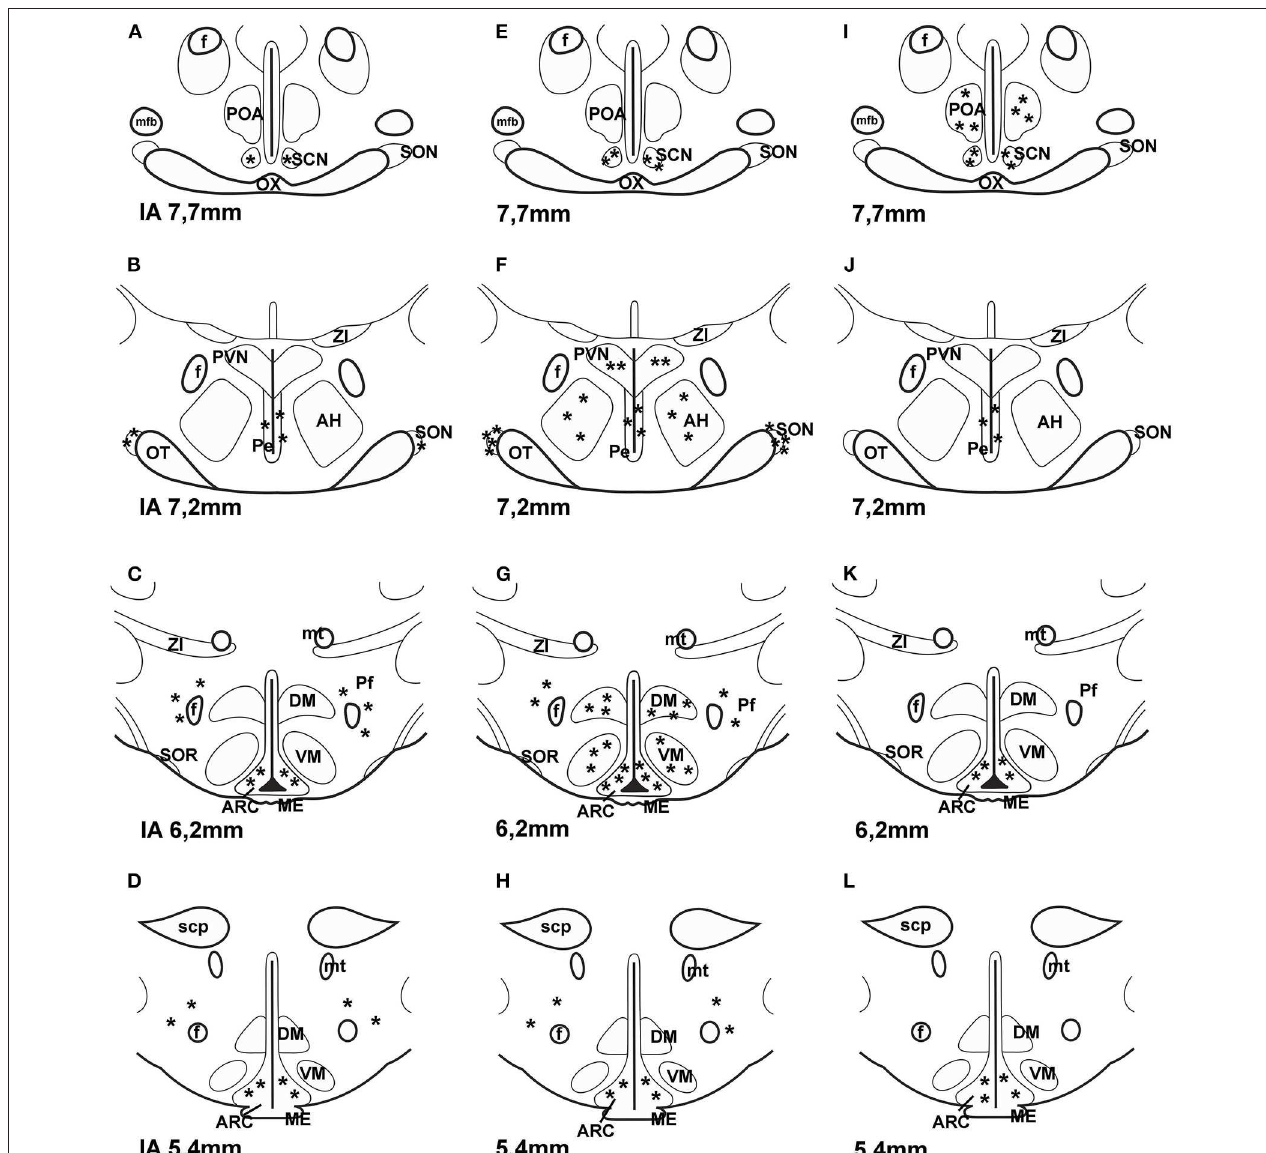
FIGURE 2 | Distribution of PAC1 receptor in frontal sections of the hypothalamus according to Paxinos and Watson’s stereotaxic coordinates. (A–D) shows data obtained by autoradiography (75). (E–H) shows distribution of PAC1 mRNA. Data were obtained by ISH (74, 77). (I–L) shows distribution of PAC1 receptor immunoreactivity using IHC (73). Asterisks indicate the place of PACAP binding, or where PAC1 mRNA was expressed or where PAC1 immunoreactivity was detected. AH, anterior hypothalamus; f, fornix; ME, median eminence; mfb, medial forebrain bundle; mt, mammillothalamic tract; OT, optic tract; OX, optic chiasm; Pe, periventricular nucleus; Pf, perifornical nucleus; POA, preoptic area; PVN, paraventricular nucleus; SCN, suprachiasmatic nucleus; scp, superior cerebellar peduncle; SON, supraoptic nucleus; SOR, retrochiasmatic portion of SON; ZI, zona incerta. Reproduced and modified from Köves et al. (46). Permission to reuse was obtained from Springer Nature. Permission # 4762591108219